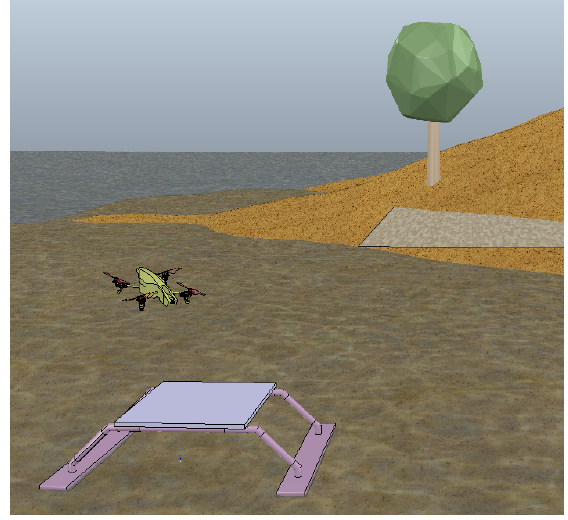
Figure 10. V-REP simulation environment for testing control strategies and interaction between